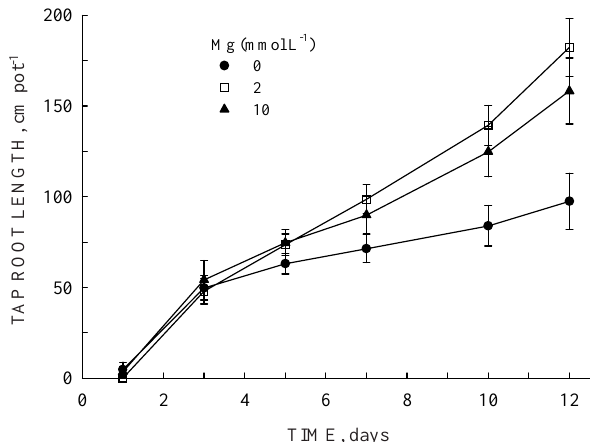
Figure 1. Mean tap root elongation of soybean genotypes N93-S-179 (N93) and Young with time of exposure to solutions in Experiment 1 without Al, at pH 4.6, and variable Mg concentrations. Vertical bars denote standard